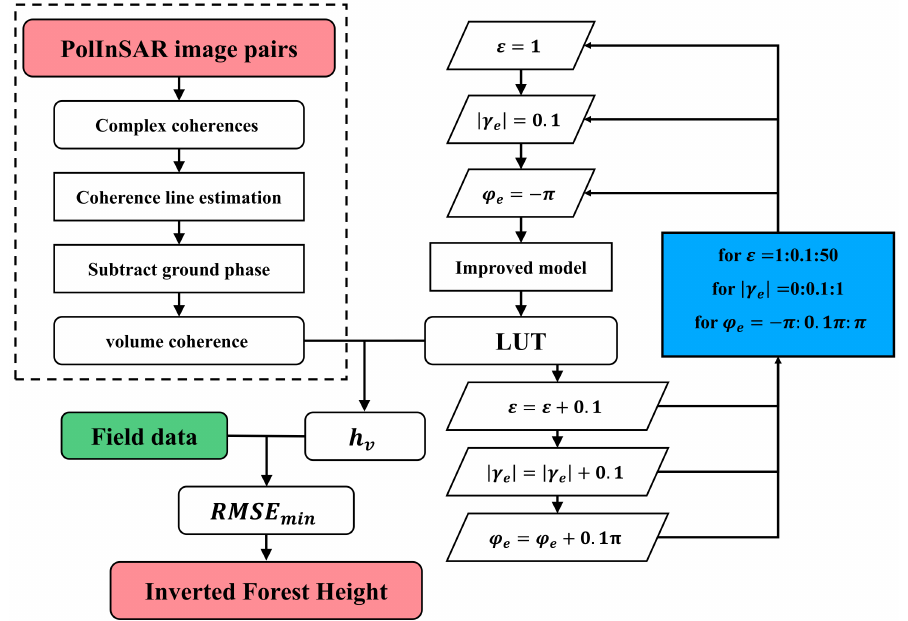
Figure 9. The inversion flow